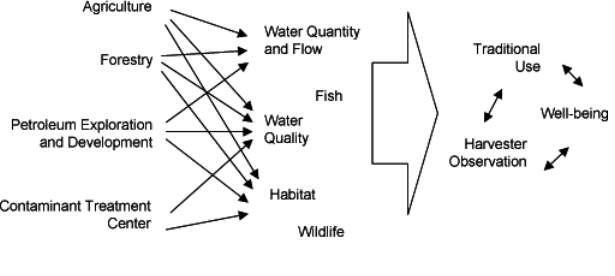
Fig. 3. The figure summarizes the perceived causes of change in the regional environment with echoed effects in the social system (traditional use and well-being). These social changes are described here as having further feedbacks within this system as changes in traditional harvesting in turn influence what, where, and how harvesters observe both in relation to the stresses created by resource development as well as changes in the environment